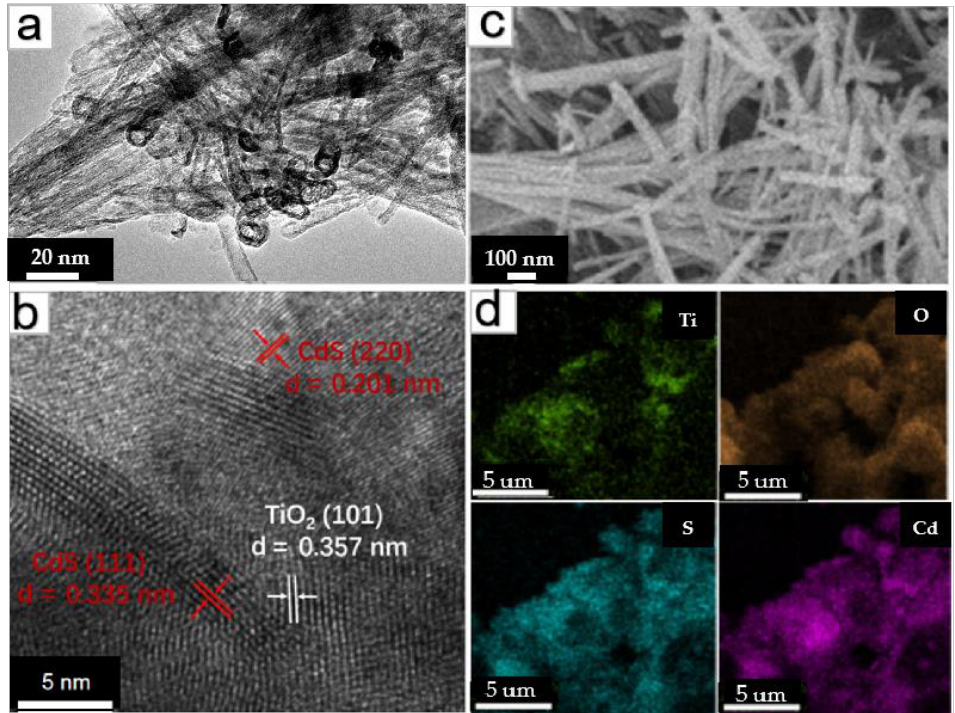
Figure 1. TEM ( a ), HR-TEM ( b ), and SEM ( c ) images of the CdS-TiO 2 NTs and mapping ( d ) of CdS-TiO 2 NTs.